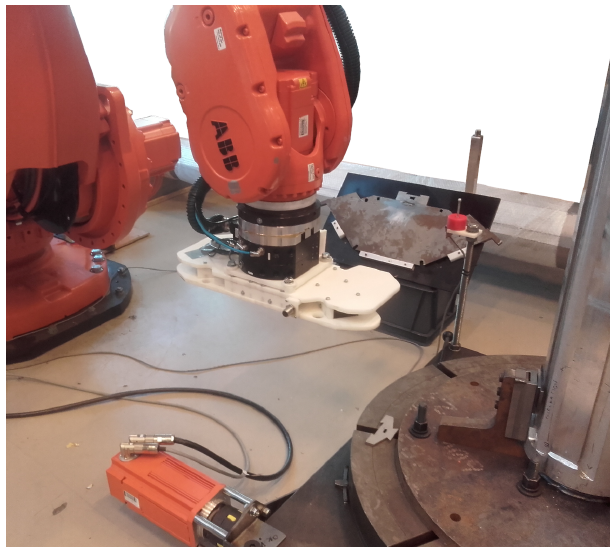
Figure 2. Photo showing the ABB6650s robot (upper left), the rotational table (lower right), the central pipe (right), the lifting tool (centre) and the pole-shoe storage table (centre back).